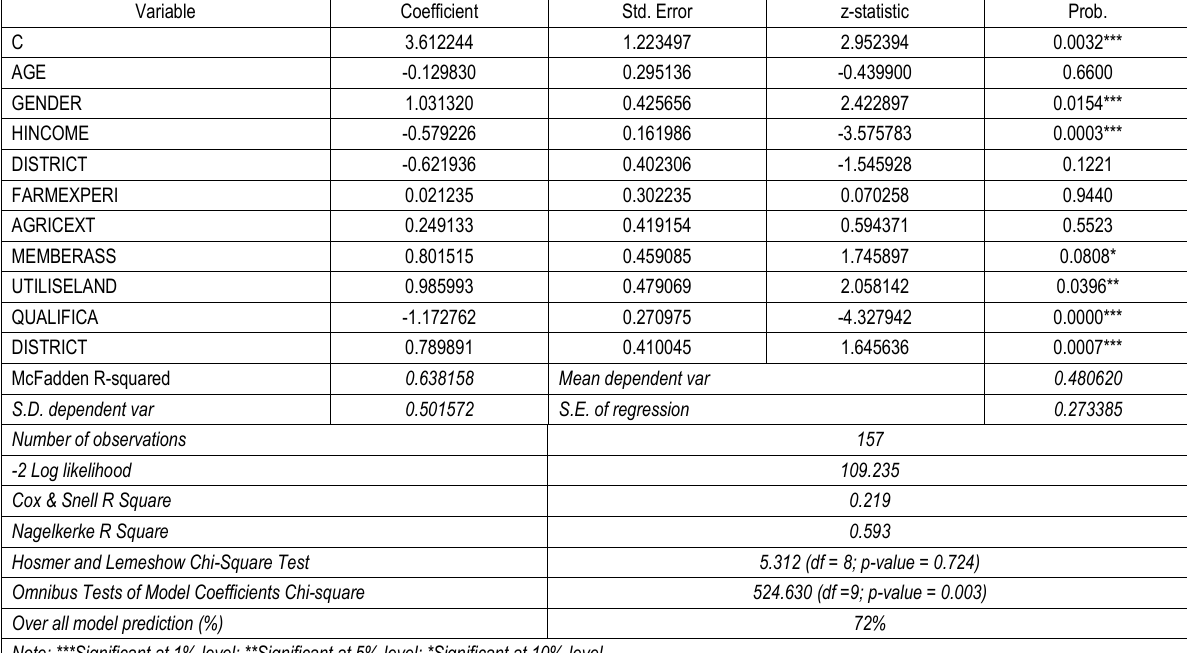
Table 2. Binary model